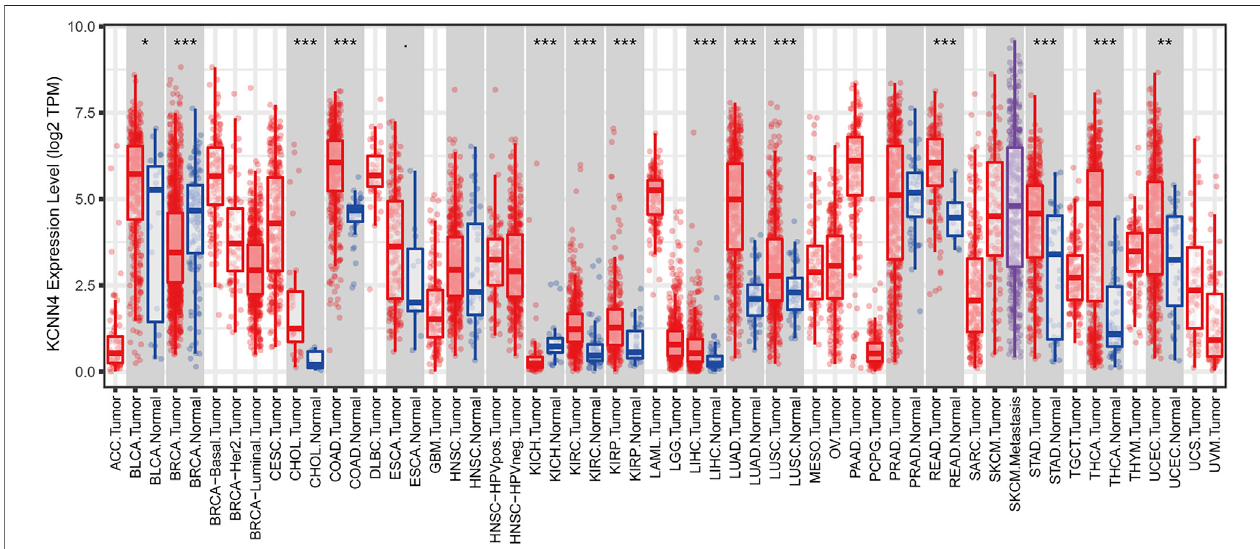
FIGURE 2 | Expression patterns of KCNN4 in pan-cancer datasets based on TIMER database. p p < 0.05, pp p < 0.01, ppp p <